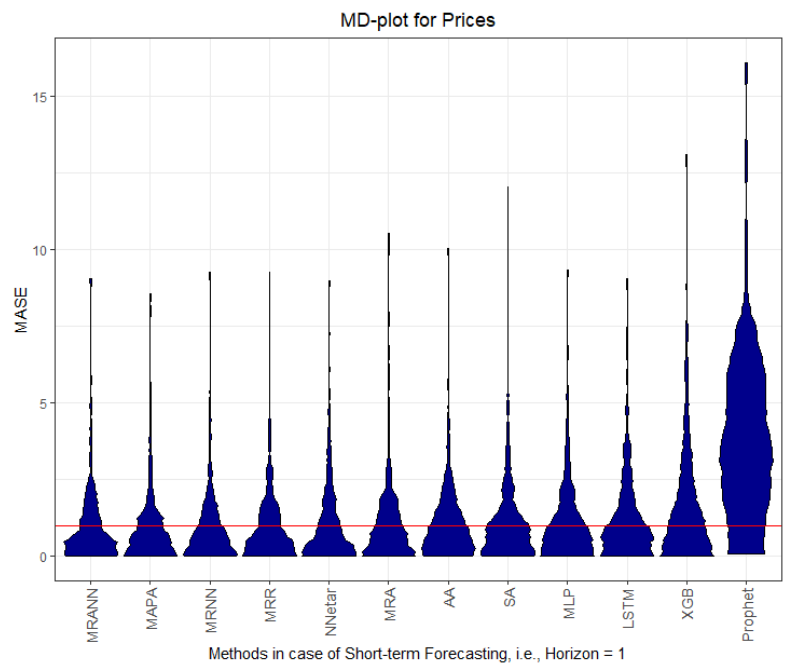
Figure 3. Mirrored density plot of Mean Absolute Scaled Errors (MASE) computed with a rolling forecasting origin for horizon 1 on dataset